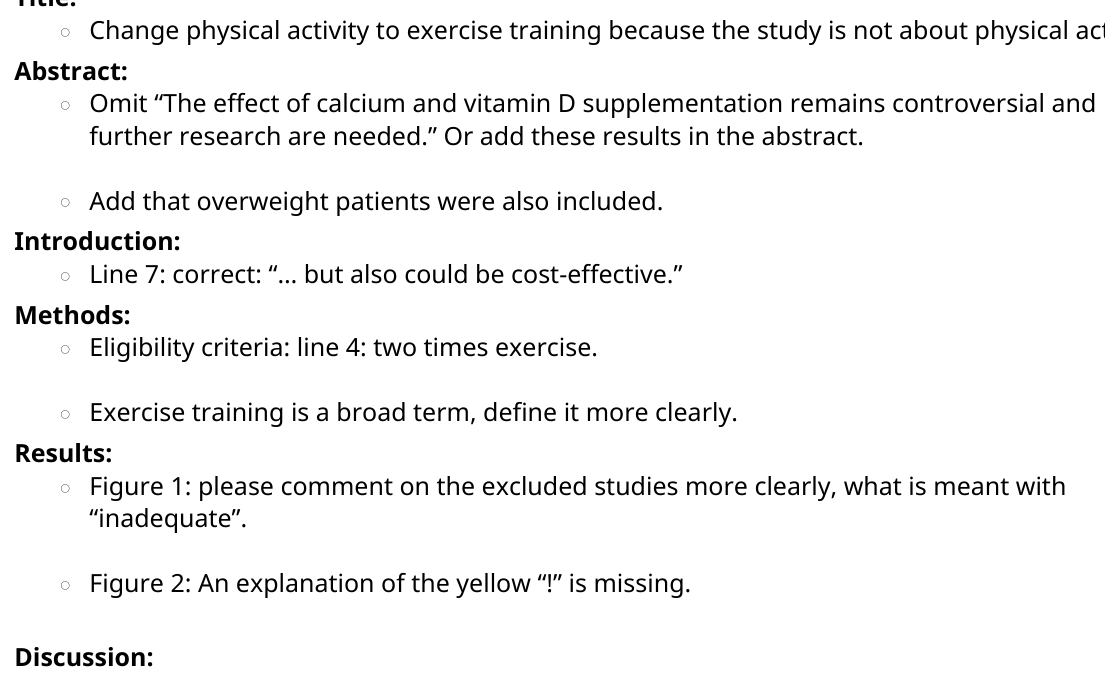
Figure 1: please comment on the excluded studies more clearly, what is meant with “inadequate”. Figure 2: An explanation of the yellow “!” is missing. ○